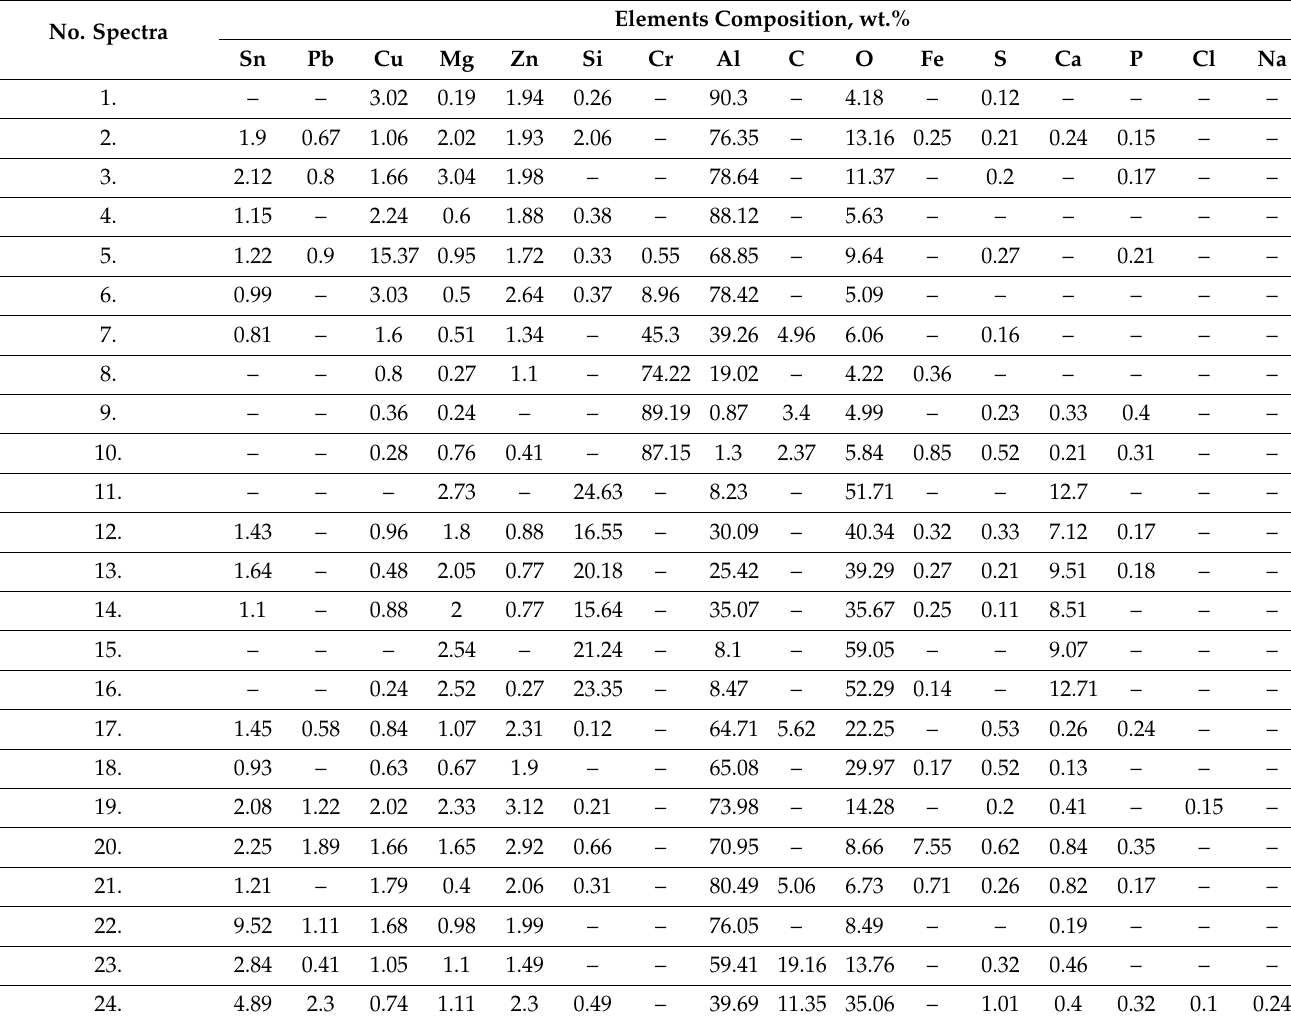
Table 12. EDS chemical identification of elements and their concentration in Al–Cr worn surface. No.